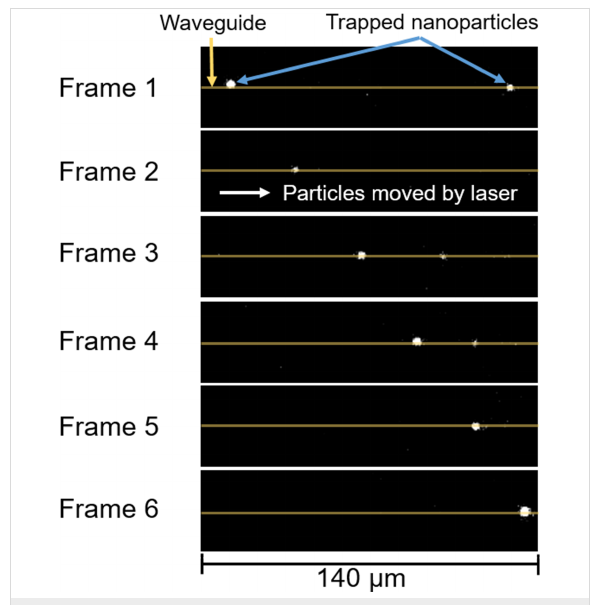
Figure 4: Microscopy images of PEG-SPIOs in aqueous solution. The laser pushes the trapped nanoparticles across the waveguide via scat- tering force (pushing force). The frames above capture the movement of trapped nanoparticles over different time points.